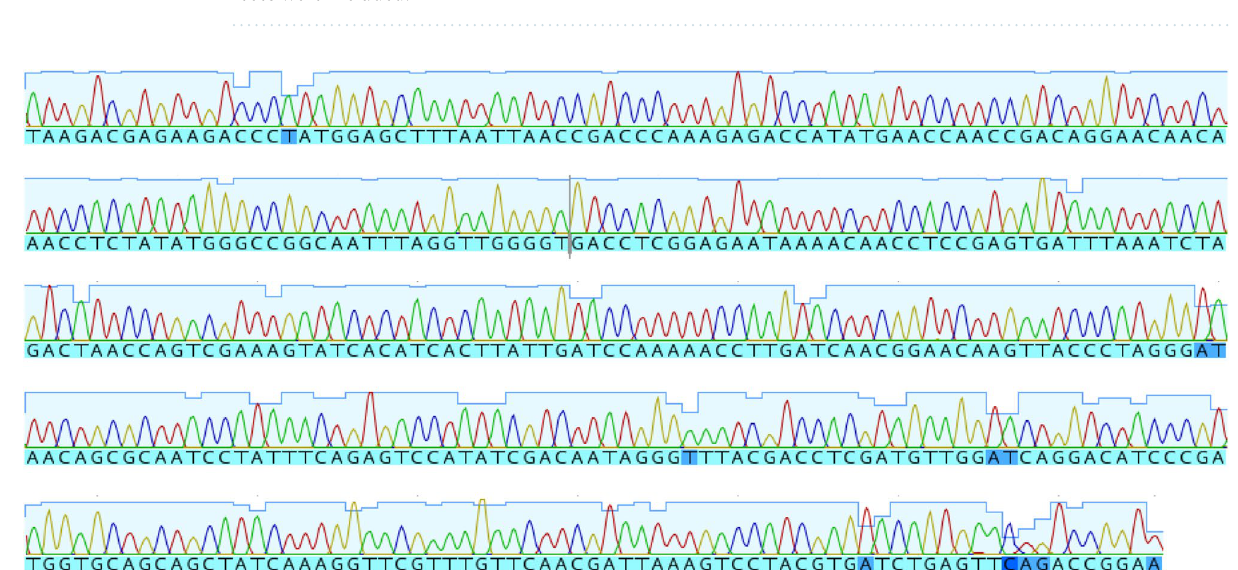
Figure 2. Phylogenetic analysis using maximum likelihood method based on the complete amino acid sequence of the polymerase protein. Representative crAssphage genomes from different genera found in human feces were included.